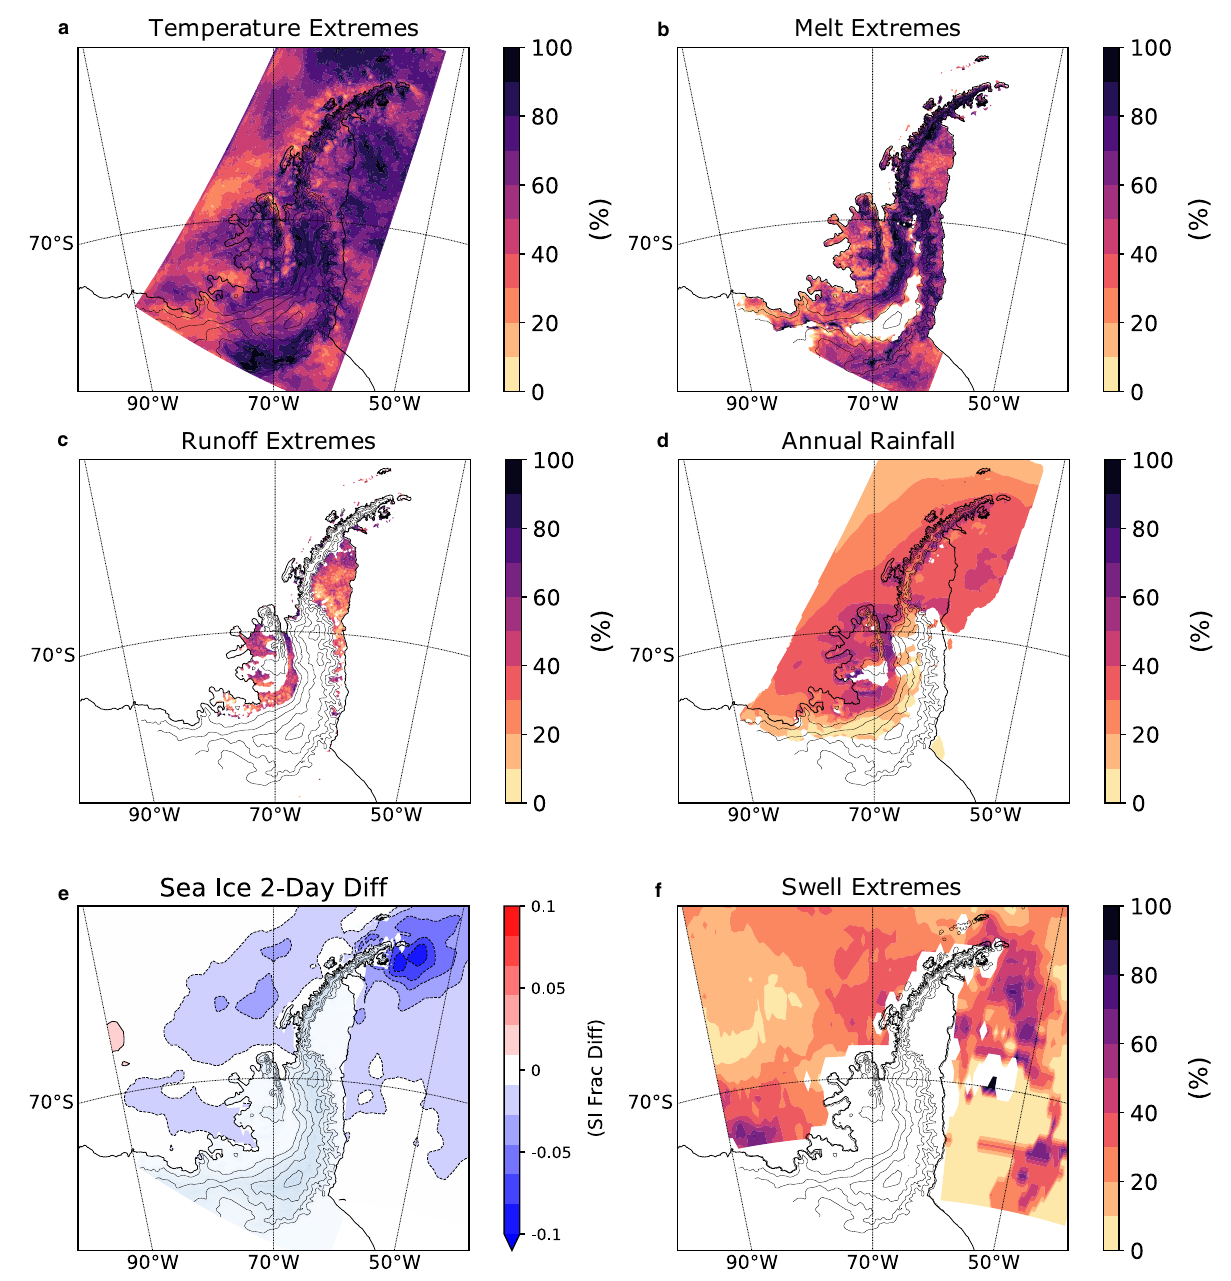
Fig. 3 Relationship between ice-shelf destabilizing extremes and ARs. The percentage of MAR a 2 m temperature occurrences b surface melt, and c runoff at or above the 99.9th percentile of the 1980 – 2019 monthly mean climatology (December – March) that occurred within 24 h before and after an AR landfall on the AP. d Percentage of total annual rainfall from 1980 to 2019 associated with AR landfalls. e The composite 2-day sea-ice fraction difference for annual AR landfalls with a maximum IVT at or above 400 kg m − 1 s − 1 ( n = 357). f Percentage of annual swells at or above the 99.9th percentile of the 1980 – 2019 monthly mean climatology associated with AR